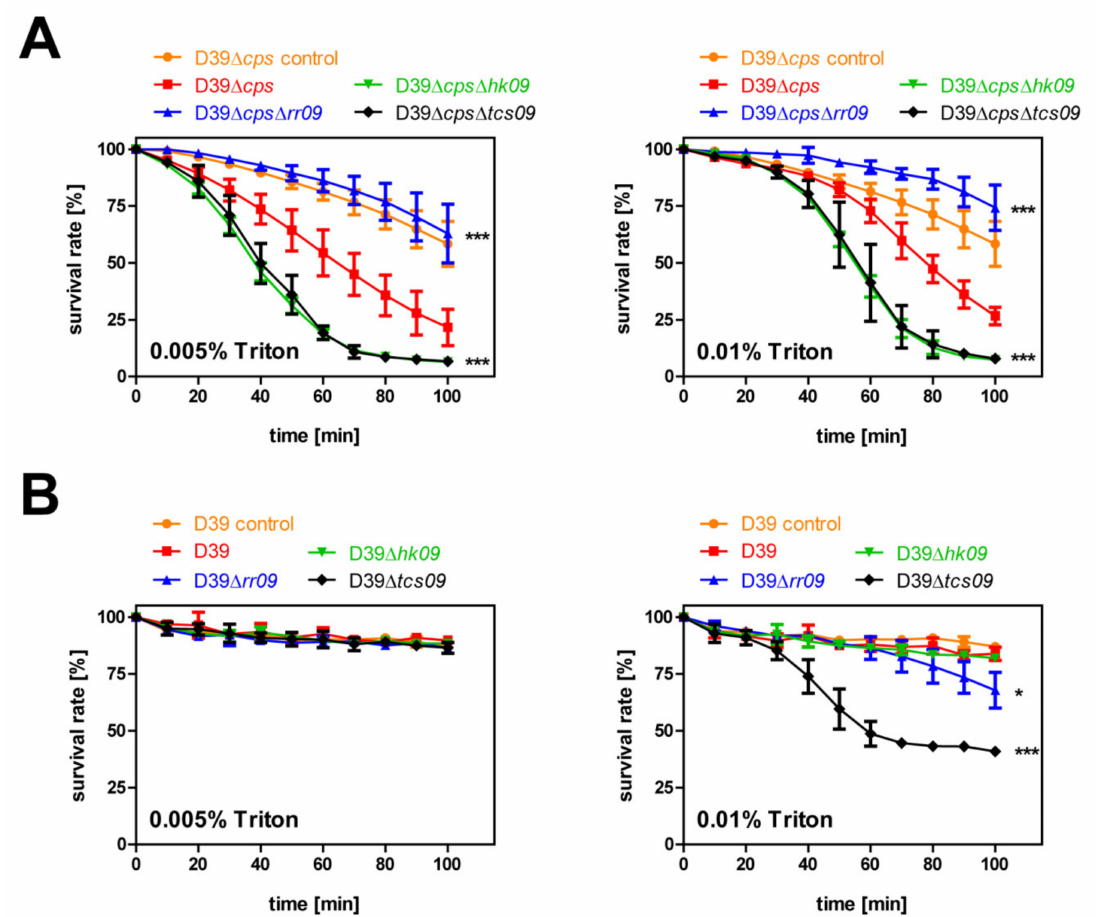
Figure 7. Effect of TCS09 in stability and autolysis in S. pneumoniae . The pneumococcal parental strains D39 ∆ cps or D39 and their isogenic mutants ∆ rr09 , ∆ hk09 , and ∆ tcs09 were cultivated in CDM until an OD 600nm 0.6, resuspended in PBS, and treated with Triton X-100. ( A ) Survival rate of nonencapsulated D39 ∆ cps and tcs09 -mutant strains. ( B ) Percentage of survived encapsulated D39 and tcs09 -mutant strains. Results are presented as the mean ± SD of the normalized percentage for three independent experiments. A two-way ANOVA proved a significance with a p -value * < 0.05 and *** < 0.001 relative to the parental pneumococcal